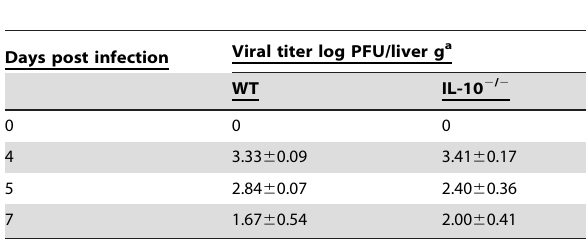
Table 3. Viral titer measurements of MCMV infected C57BL/6 (WT) and IL-10 2 / 2